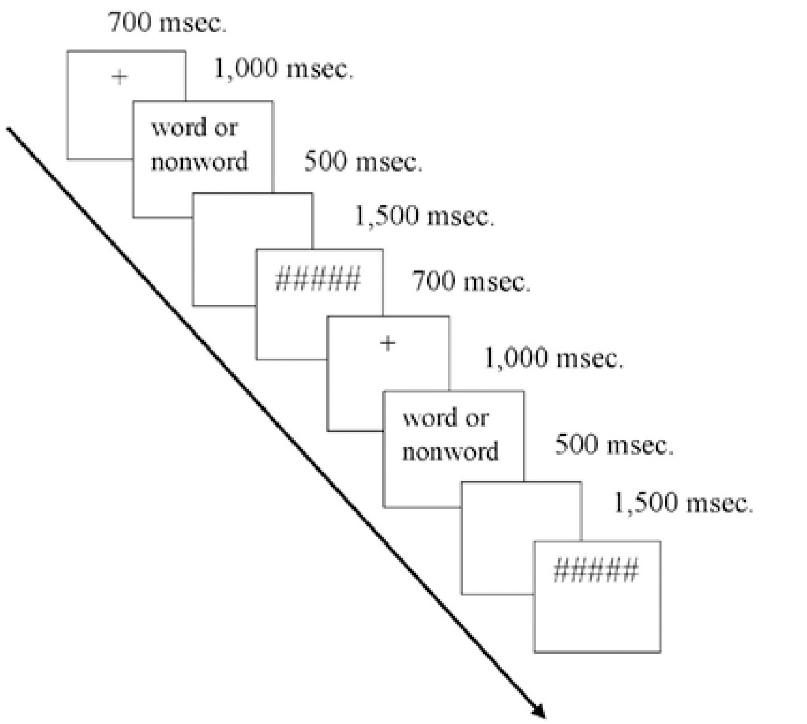
Fig 1. Experimental timeline for the LDT experiments.